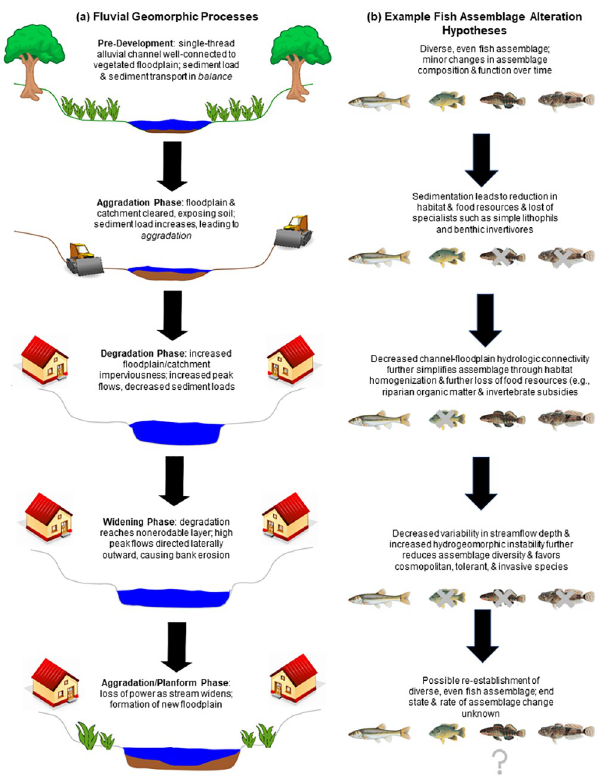
Fig 1. Conceptual depiction of urban stream channel hydrogeomorphic evolution with example fish assemblage alterations. (a) Conceptual depiction of fluvial geomorphic processes commonly observed during different phases of urban development, which can lead to variable responses including reduced sinuosity and increased sediment transport [29, 30]; altered slope, bed and bank materials, and riparian vegetation [31]; and reduced large wood, connectivity to the riparian zone, and retention of organic matter [32, 33]. Note that the three post-development phases (1) do not all necessarily occur and (2) may not proceed in the order depicted. (b) Examples of hypothesized impacts on urban-induced geomorphic alterations on fish assemblages. Fish species (from left to right) are Creek Chub ( Semolitus atromaculatus ), Green Sunfish ( Lepomis cyanellus ), Rainbow Darter ( Etheostoma caeruleum ), and Mottled Sculpin ( Cottus bairdii